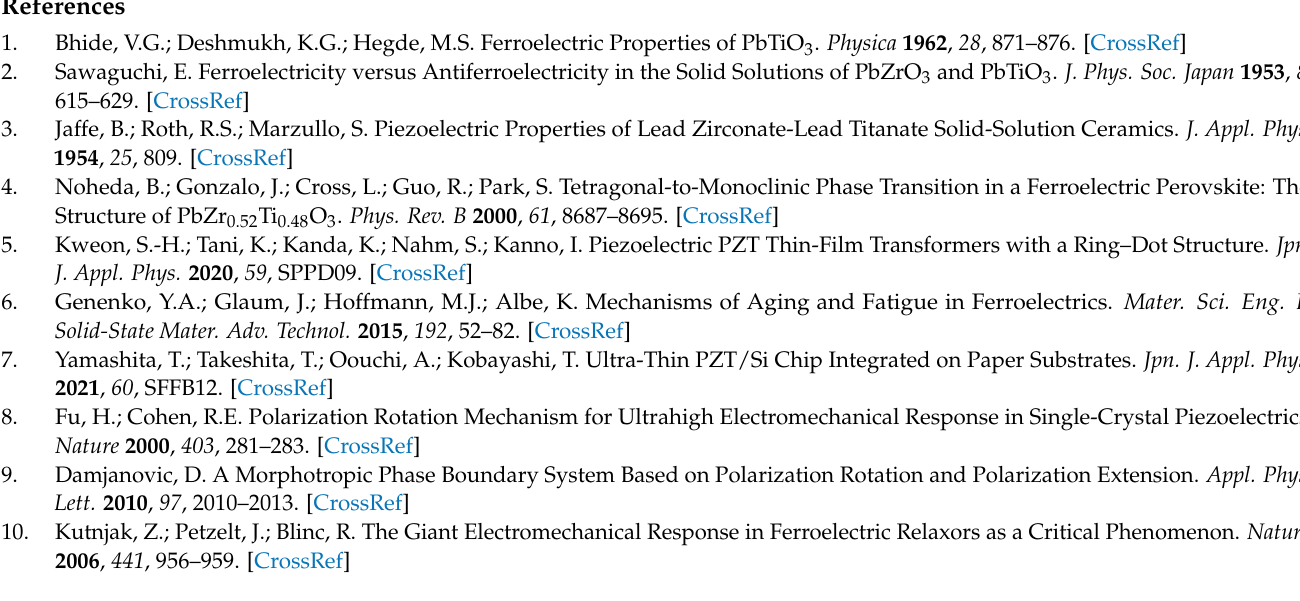
in the unit cells of the orthorhombic cells; Table S4: Structural parameters of the rhombohedral BiFeO 3 cell (space group R 3) with an antiferromagnetic spin configuration; Table S5: Structural parameters of the rhombohedral (Bi 5 La)Fe 6 O 18 cell (space group P 3) with an antiferromagnetic spin configuration; Table S6: Structural parameters of the rhombohedral (Bi 2 La)Fe 3 O 9 cell (space group P 3) with an antiferromagnetic spin configuration; Table S7: Structural parameters of the rhombohedral (BiLa)Fe 2 O 6 cell (space group R 3) with an antiferromagnetic spin configurations; Table S8: Struc- tural parameters of the rhombohedral (BiLa 2 )Fe 3 O 9 cell (space group P 3) with an antiferromagnetic spin configuration; Table S9: Structural parameters of the rhombohedral (BiLa 5 )Fe 6 O 18 cell (space group P 3) with an antiferromagnetic spin configuration; Table S10: Structural parameters of the rhombohedral LaFeO 3 cell (space group R 3) with an antiferromagnetic spin configuration; Table S11: Structural parameters of the tetragonal BiFeO 3 cell (space group P 4 mm ) with an antiferromagnetic spin configuration; Table S12: Structural parameters of the tetragonal (Bi 7 La)Fe 8 O 24 cell (space group P 4 mm ) with an antiferromagnetic spin configuration; Table S13: Structural parameters of the tetrago- nal (Bi 3 La)Fe 4 O 12 cell (space group P 4 mm ) with an antiferromagnetic spin configuration; Table S14: Structural parameters of the tetragonal (Bi 5 La 3 )Fe 8 O 24 cell (space group P 4 mm ) with an antiferromag- netic spin configuration; Table S15: Structural parameters of the tetragonal (BiLa)Fe 2 O 6 cell (space group P 4 mm ) with an antiferromagnetic spin configuration; Table S16: Structural parameters of the tetragonal (Bi 3 La 5 )Fe 8 O 24 cell (space group P 4 mm ) with an antiferromagnetic spin configuration; Table S17: Structural parameters of the tetragonal (BiLa 7 )Fe 8 O 24 cell (space group P 4 mm ) with an antiferromagnetic spin configuration; Table S18: Structural parameters of the tetragonal LaFeO 3 cell (space group P 4 mm ) with an antiferromagnetic spin configuration; Table S19: Structural parameters of the orthorhombic BiFeO 3 cell (space group P 2 1 / m ) with an antiferromagnetic spin configuration; Table S20: Structural parameters of the orthorhombic (BiLa)Fe 2 O 6 cell (space group P 2 1 / m ) with an antiferromagnetic spin configuration; Table S21: Structural parameters of the orthorhombic LaFeO 3 cell (space group P 2 1 / m ) with an antiferromagnetic spin